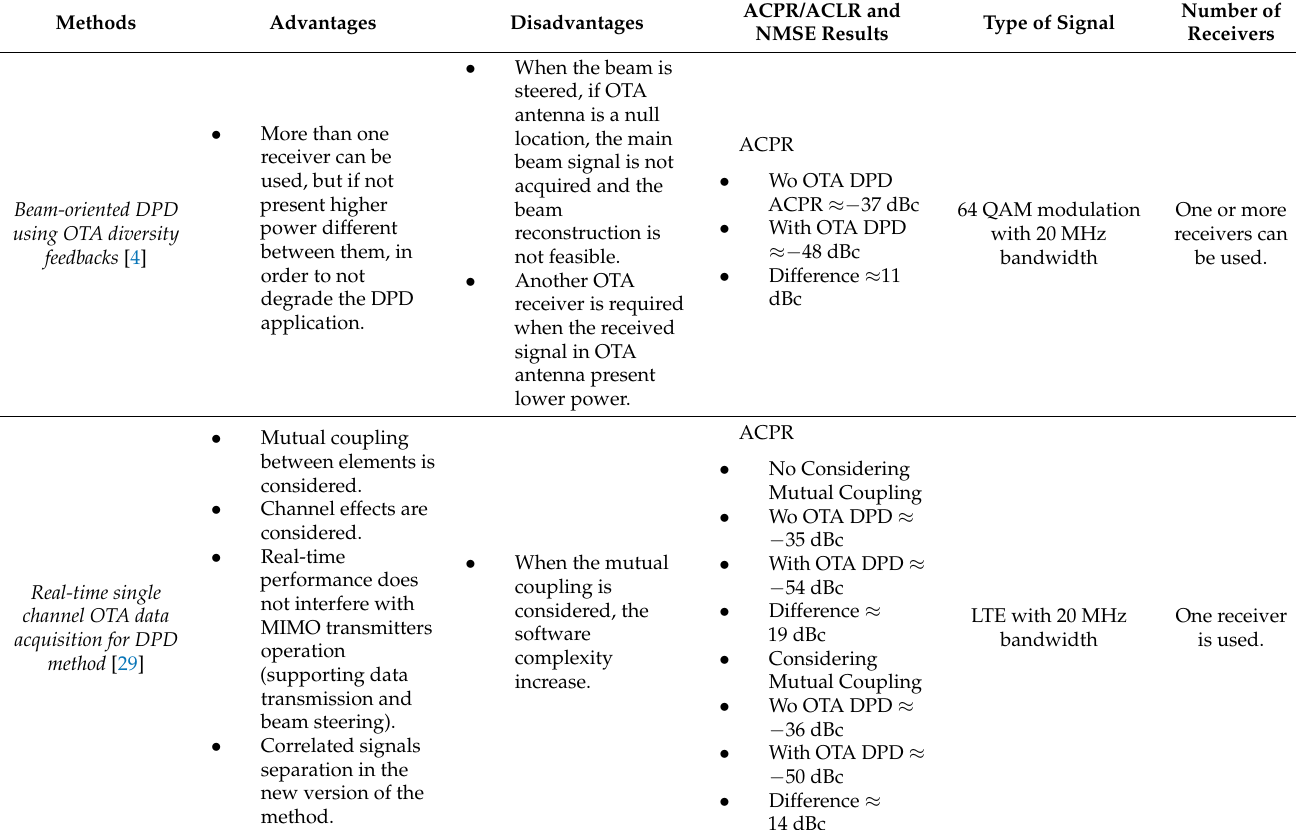
Table 1. OTA DPD methods for MIMO systems